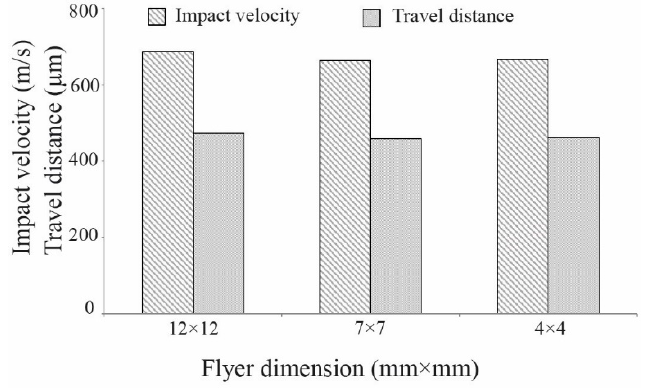
Figure 7. Average flyer velocity and travel distance for flyers with dimensions of 12 mm × 12 mm, 7 mm × 7 mm and 4 mm × 4 mm ( E = 3.1 J, D = 4 mm, t = 75 μ m, L = 525 μ m).